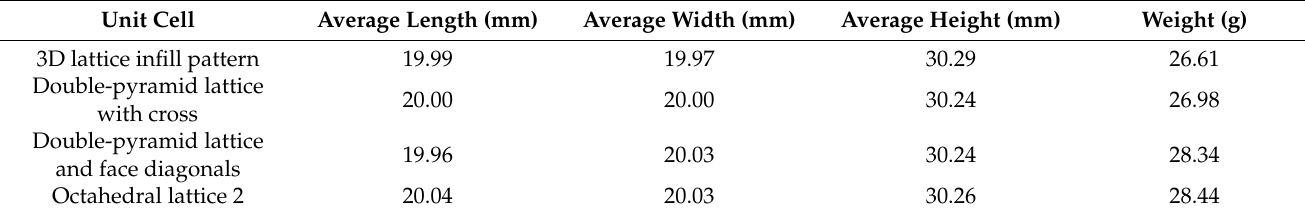
Table 5. Dimensions and masses of the